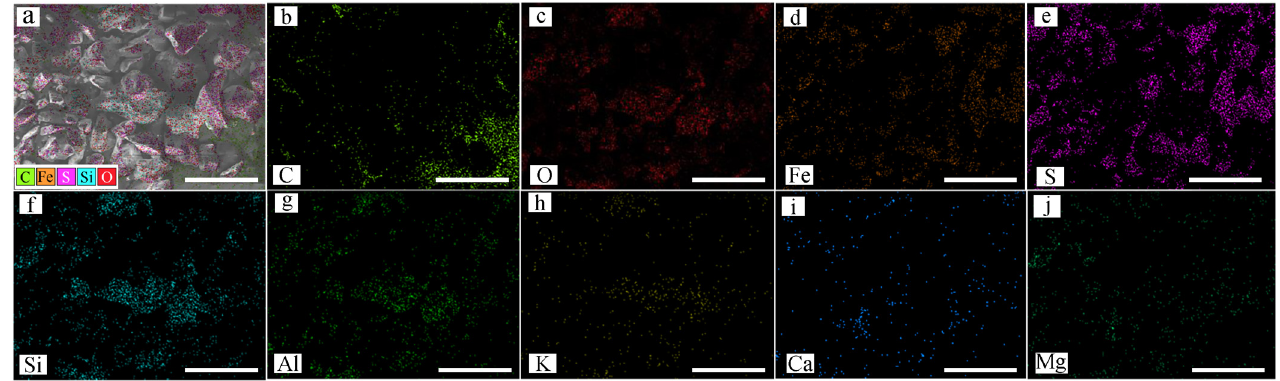
Figure 7. EDS element maps of sulfide concentrated gold sample: ( a ) combined image, ( b – j ) images of individual elements, the scale bar is 250 μ m.